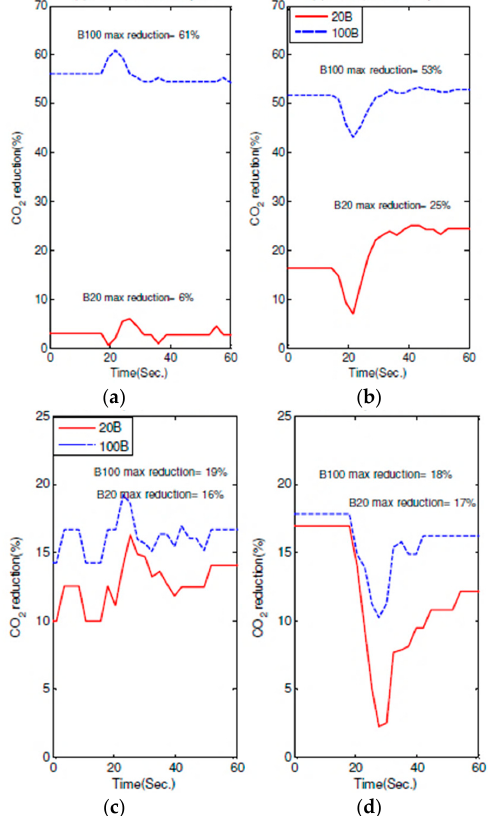
Figure 11. ( a , b )Time trace of percentage CO 2 emission reduction using the 20 B blend and 100 B during the 100–5000 rpm speed transient condition at 420 Nm engine load. CO 2 emission percentage reduction of CI engine with time by using different biodiesel blends at 1500 rpm engine speed for ( c ) positive and ( d ) negative torque transition. Figure 11c,d represents the CI engine’s CO 2 emission reduction during the positive torque transient operation. This caused a non-uniform CO 2 emission reduction. Figure 11c shows this inconsistent behaviour. Conversely, the CO 2 emission was found to reduce by up to 16% and 19%, respectively, when the engine was run with the 20 B blend and 100 B. During the negative torque transition, with the same fuels, the CO 2 emission reduced by up to 18% when compared to diesel. Under the speed transient (1000–1500 rpm) operating conditions investigated, the CO 2 emission was maximally reduced due to the lower